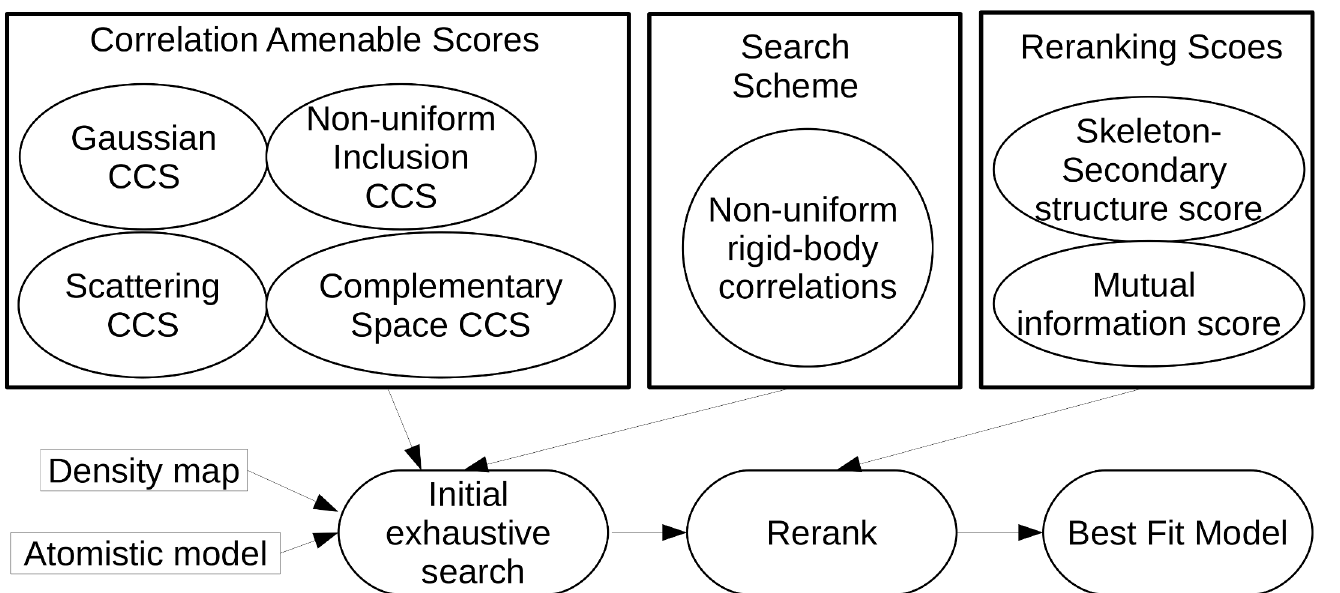
Fig 1. Control flow. A typical control flow of the 3D EM map fitting algorithm developed in this work. The first step of a fitting procedure is the inital exhaustive search. Here one needs to define suitable scoring functions that are amenable for fast correlation computation via the chosen search scheme. Here, we are using FFT-based algorithms for the fast computation of non-uniform rigid-body correlations. The scoring functions may account for various structural aspects such as scattering potential or pockets in the molecular surface. The exhaustive search is followed by an information driven reranking scheme which among others might include the mutual information score or skeleton-secondary structure score. The final output of the procedure will be the best fit between the atomic structure and the 3D EM map.